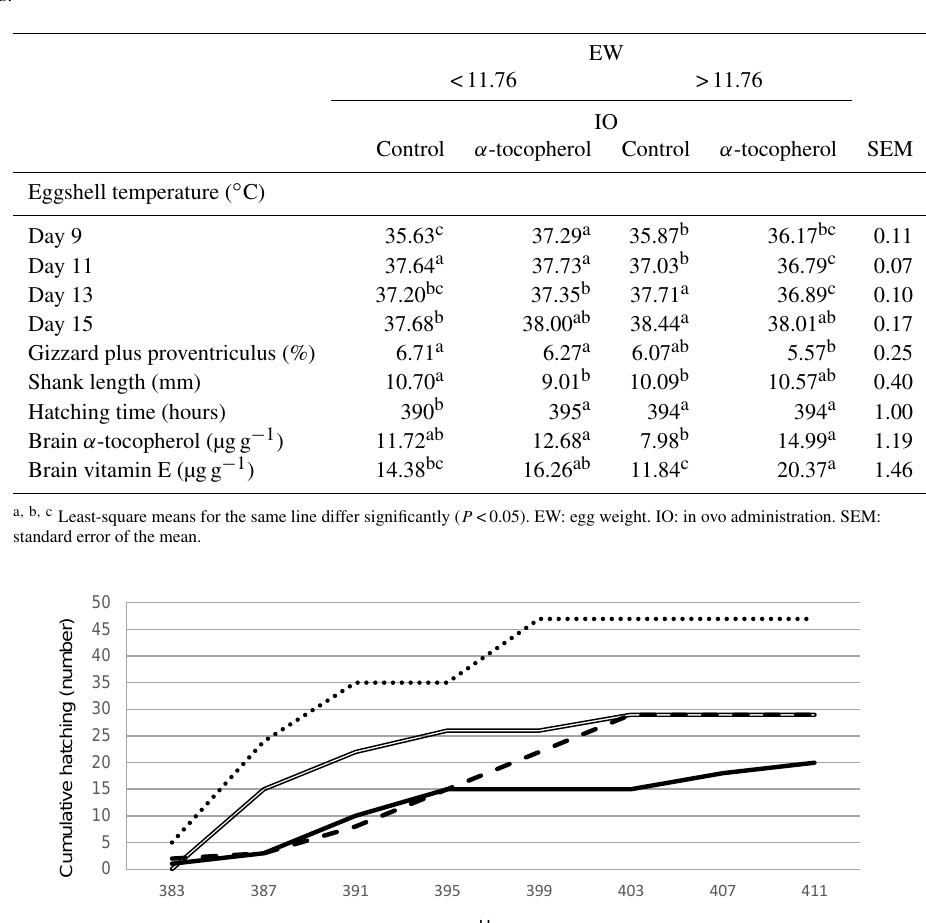
Table 5. Interaction effect of egg weight and in ovo administration of α -tocopherol on the eggshell temperature at days 9, 11, 13 and 15 of incubation in the quail embryo, gizzard plus proventriculus weight, shank length, hatching time and brain α -tocopherol and vitamin E levels in the quail chicks.